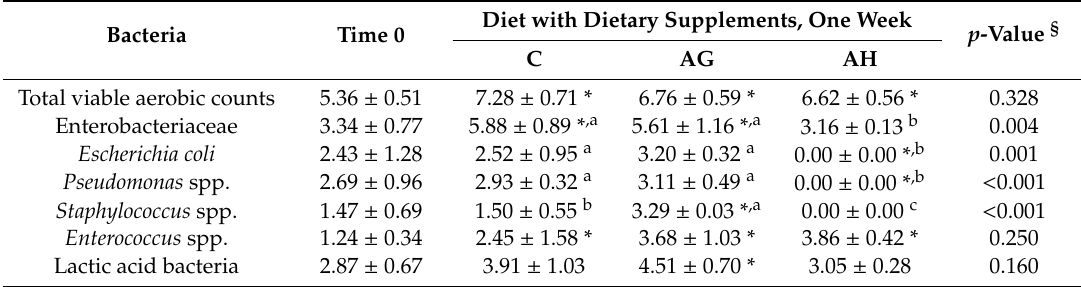
Table 2. Bacterial counts (log CFU per samples log CFU per samples ± s.d.) obtained from honey bees’ ventriculum after one week of dietary supplement administration. Bacteria Time